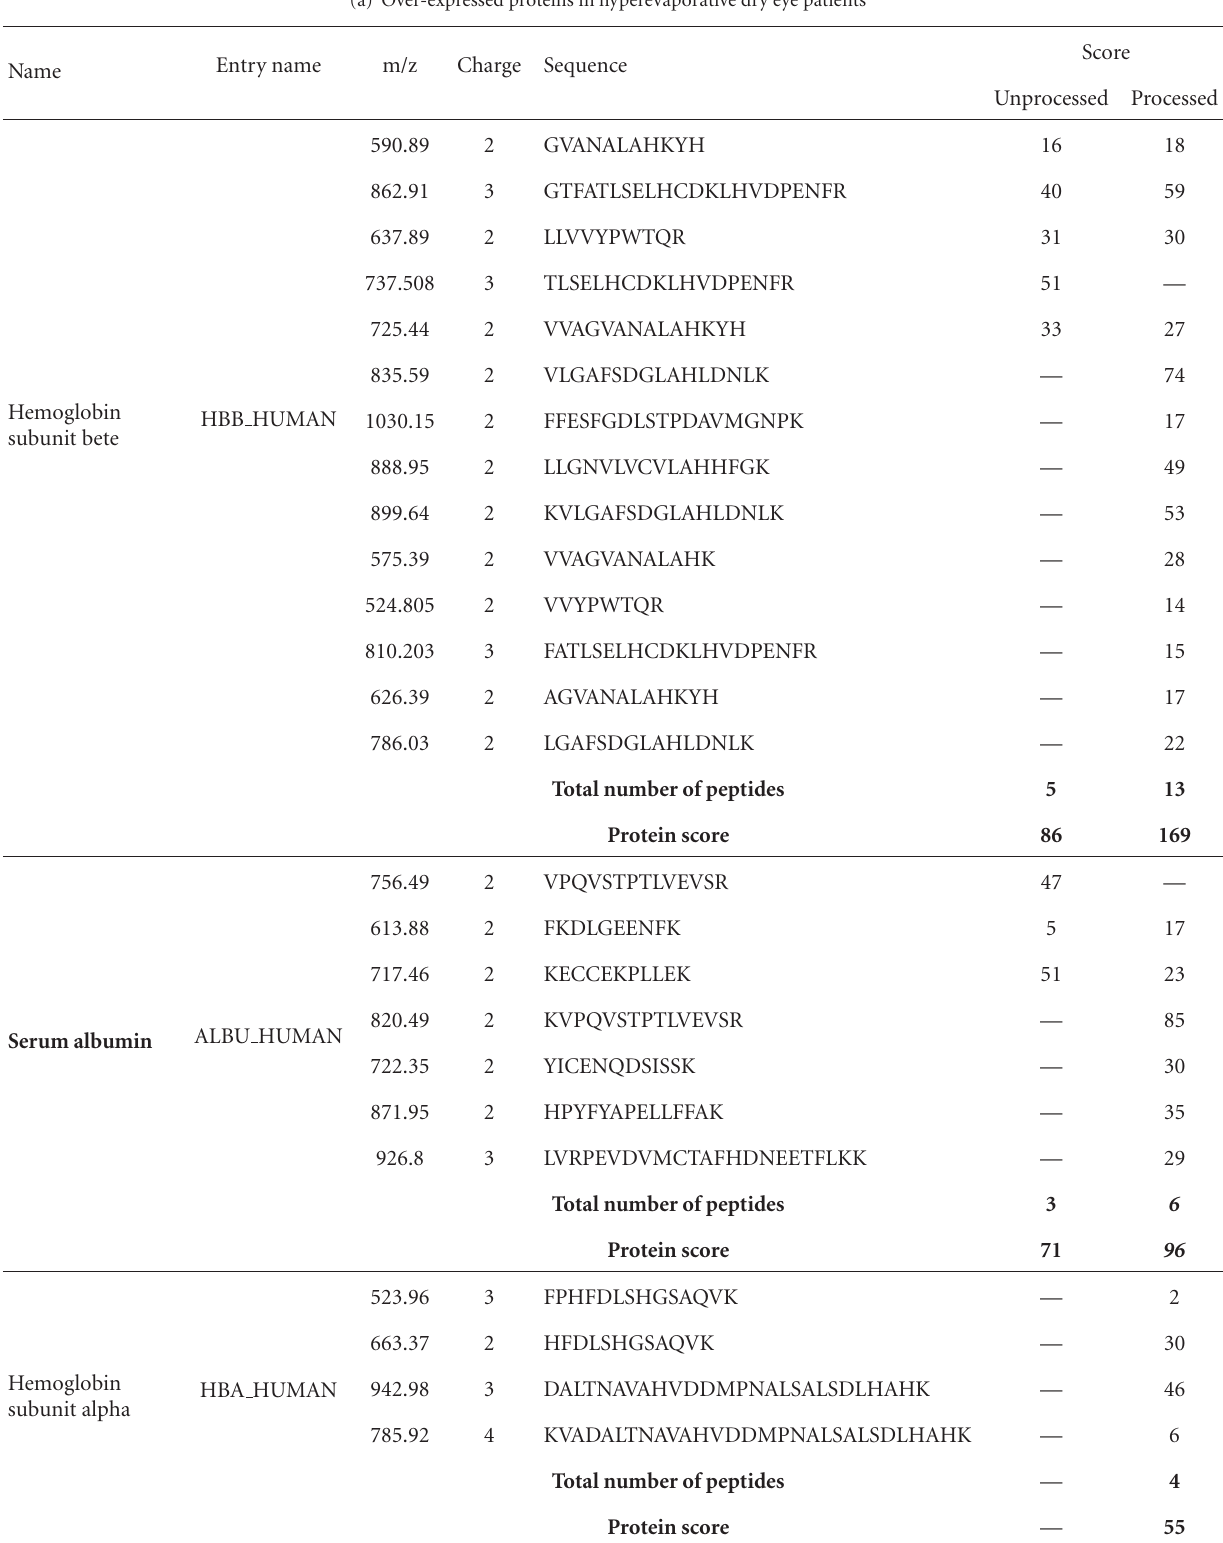
Table 2: List of the peptides identified using the include lists from unprocessed and processed data. Bold italic proteins indicate abundance variations in agreement with previous outcomes